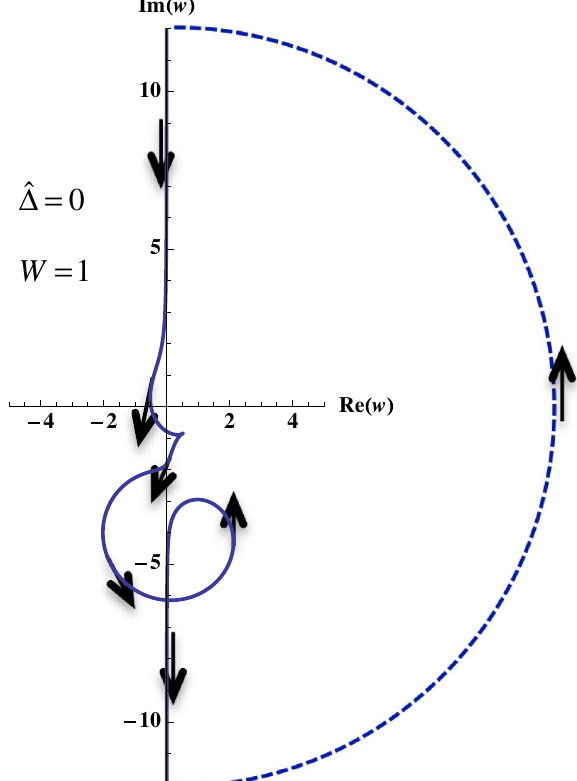
FIG. 9. Contour of w ð C Þ (with scaled down semicircle) for zero detuning ^(cid:2) ¼ 0 and energy distribution shown in Fig.